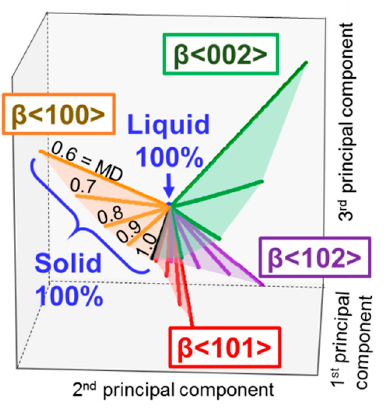
Figure 4. Representation of the simulated spectral dataset ( σ = 0%) dimensionally reduced to the first three principal components of principal component analysis (PCA). first three principal components of principal component analysis